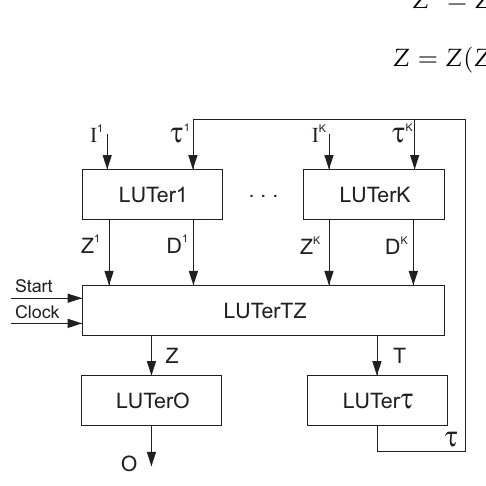
Figure 26. Structural diagram of P T Y Mealy